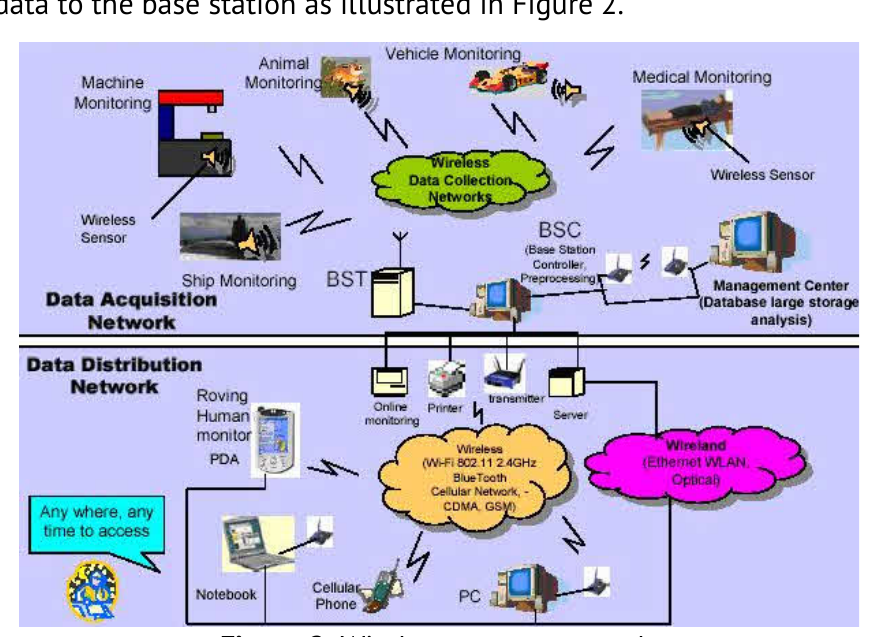
Figure 2. Wireless sensor